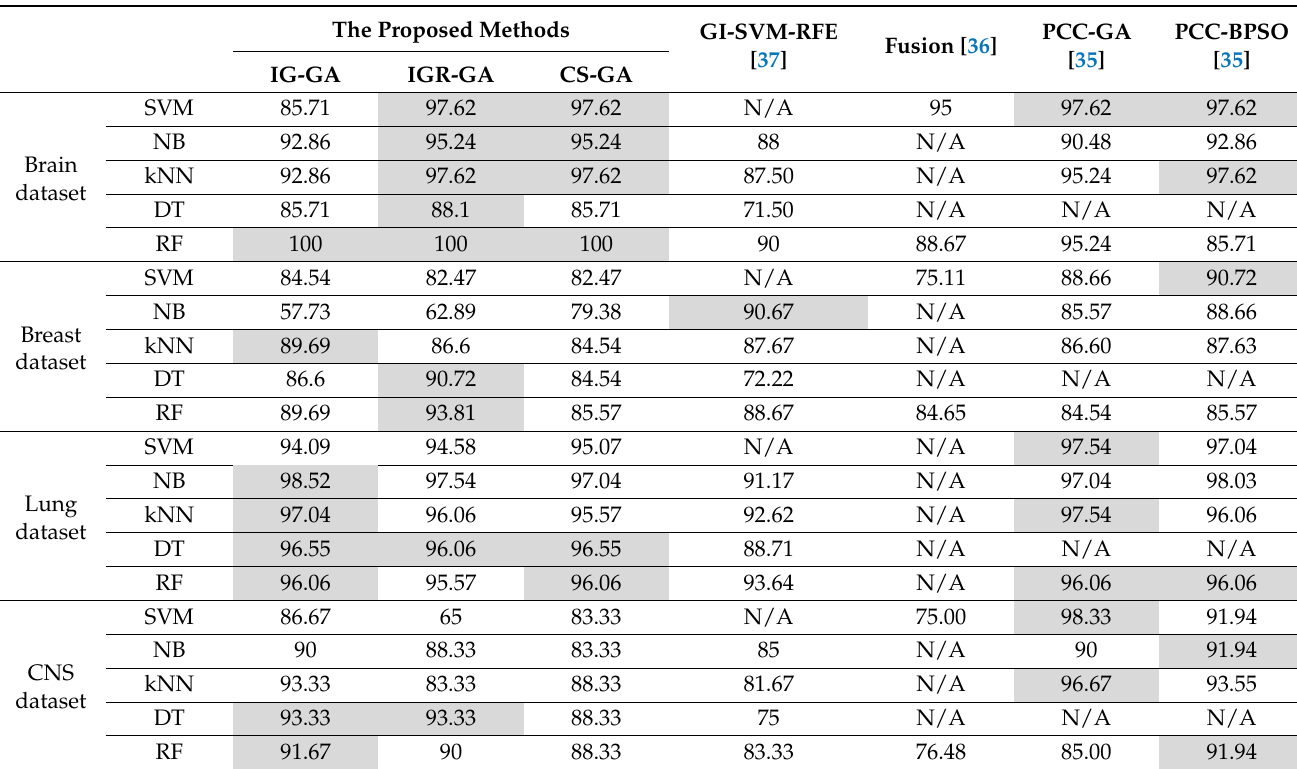
Table 8. The accuracy comparison of the proposed hybrid filter-genetic feature selection methods with the previous